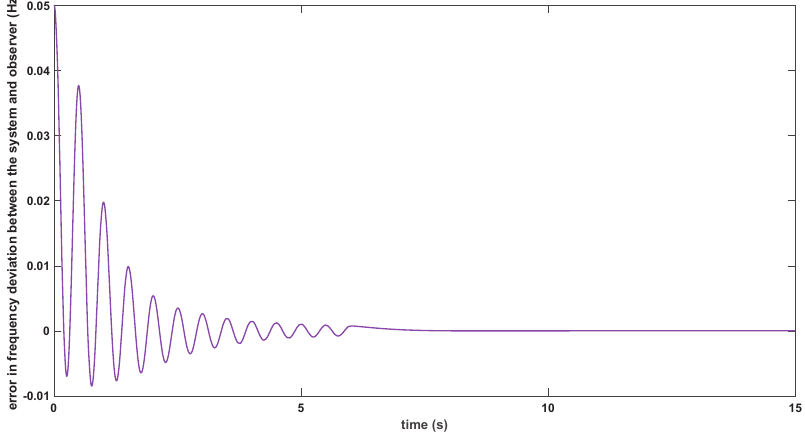
Figure 5. Error in frequency deviation between the system and